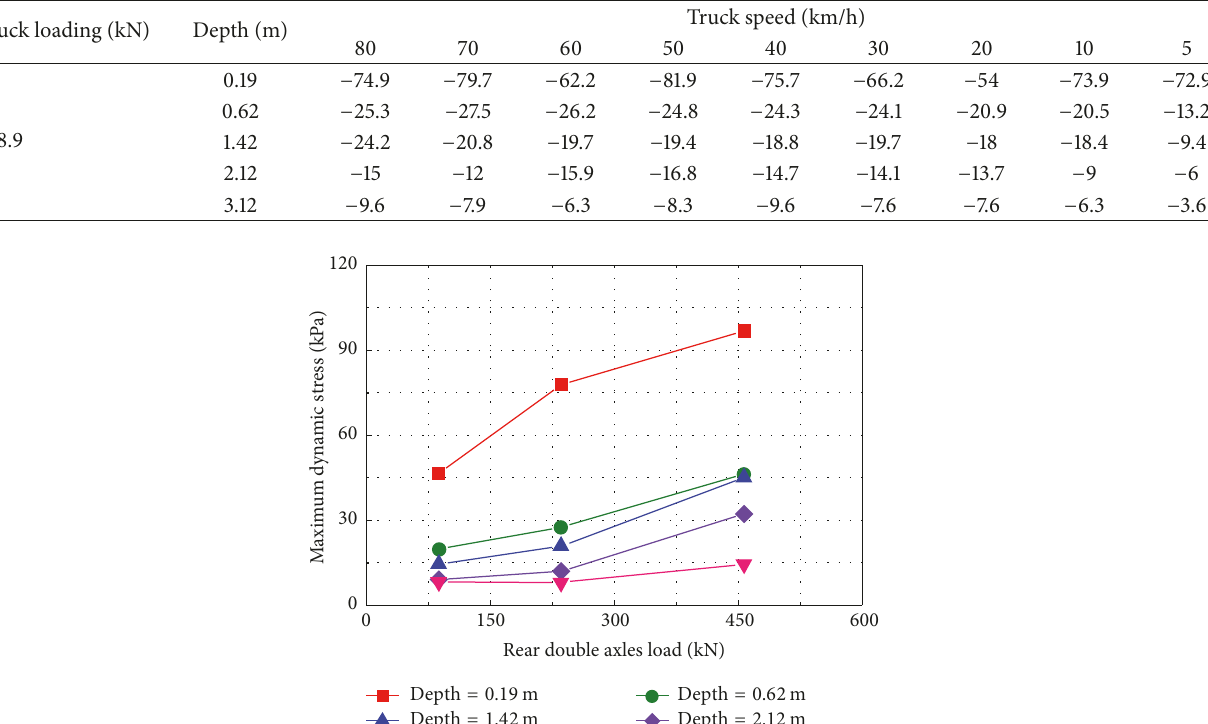
Table 3: Maximum dynamic stress at different truck speeds.